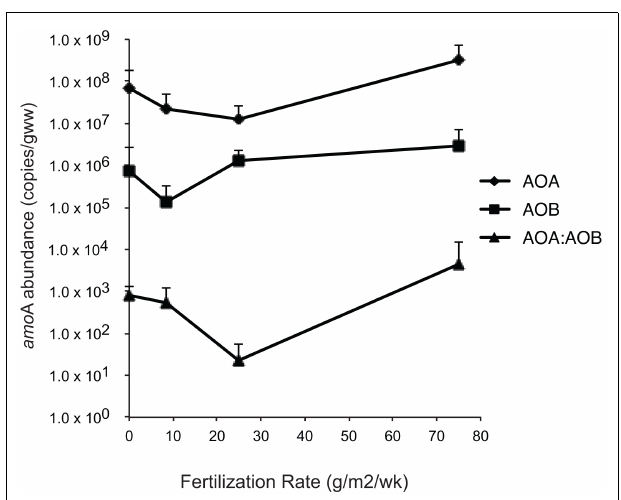
FIGURE 6 |Abundance of betaproteobacterial and archaeal amo A genes and ratios of amo A genes relative to levels of fertilization.